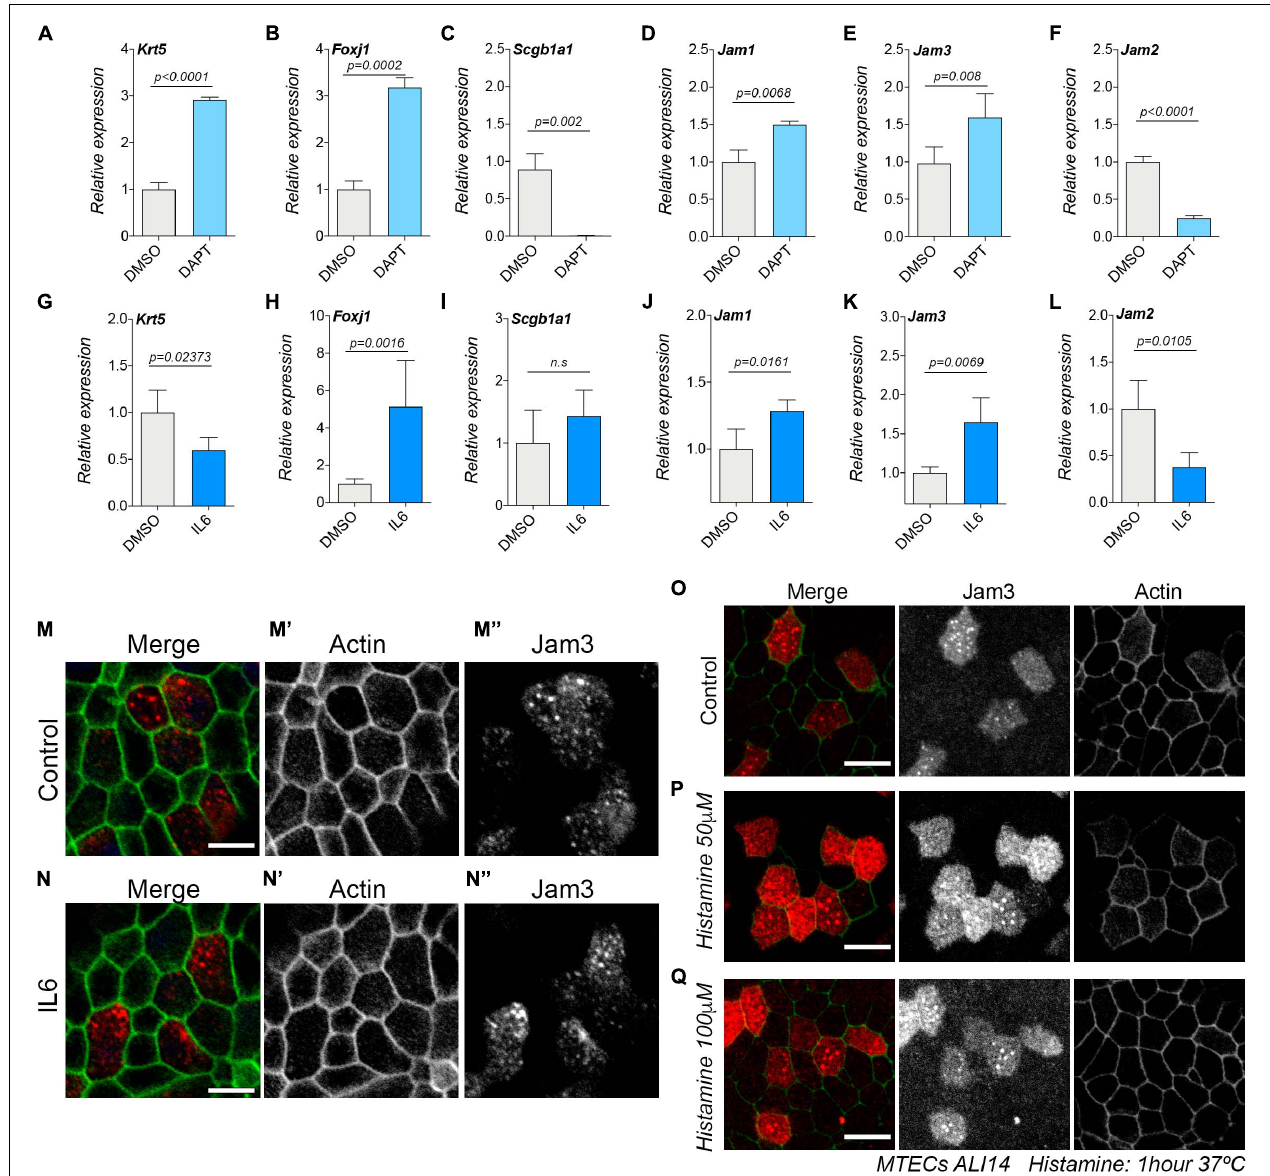
FIGURE 7 | Junctional adhesion molecule 3 (Jam 3) expression is enhanced in MTECs treated with IL6 during differentiation. (A–F) mRNA expression levels of Krt5 for basal cells (A) , Foxj1 for MCCs (B) , and Scgb1a1 for club cells (C) , Jam1 (D) , Jam3 (E) , and Jam2 (F) in MTECs treated with DMSO or DAPT for 14 days. (G–L) mRNA expression levels of Krt5 for basal cells (G) , Foxj1 for MCCs (H) , and Scgb1a1 for club cells (H) , Jam1 (I) , Jam3 (K) , and Jam2 (L) in MTECs treated with PBS or IL6 for 14 days. Mean expression values relative to DMSO-treated cells and standard deviation as error bars were plotted for each lineage marker, n = 4. (M–N) Jam3 localization in MTECs treated for 14 days with PBS (M) or IL6 (N) . The cell membrane was labeled using actin in green (gray in panels M’,N’ ) and Jam3 in red (gray in panels M”,N” ). (O–Q) Jam3 localization in MTECs treated for 1 h with PBS (O) or two concentrations of histamine (P,Q) . Scale bar in panels (M–Q) represents 20 µ m. p -values in all conditions were obtained using the t